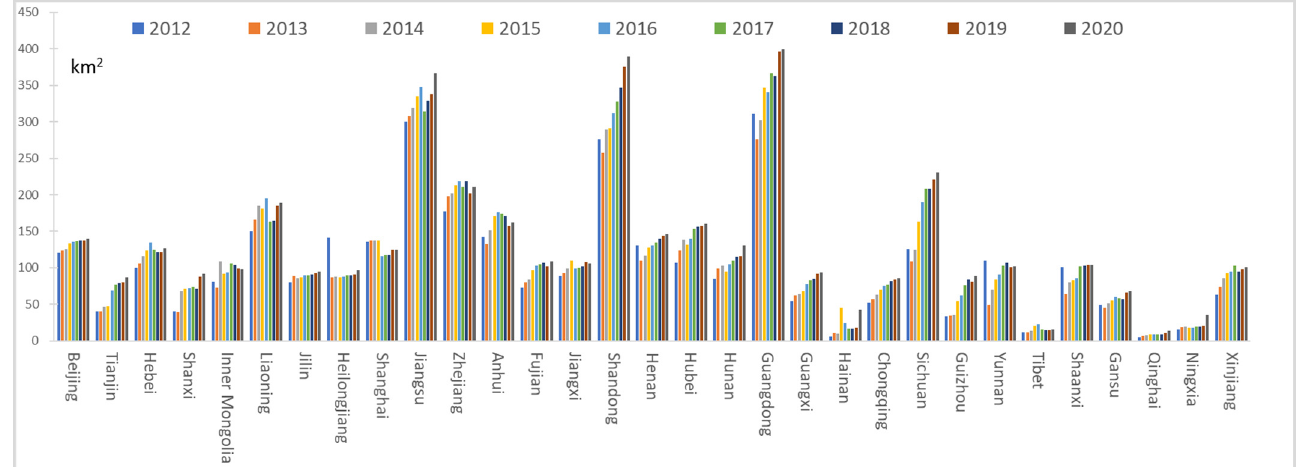
Figure 8. Analysis of change of urban service-land.